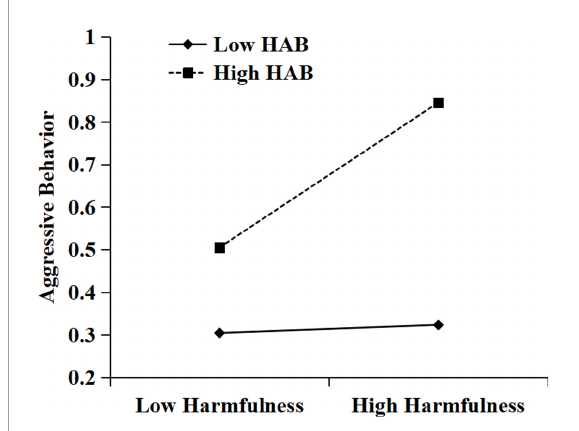
FIGURE3 The moderating role of hostile attribution bias in the correlation between harmfulness and aggressive behavior. HAB, hostile attribution